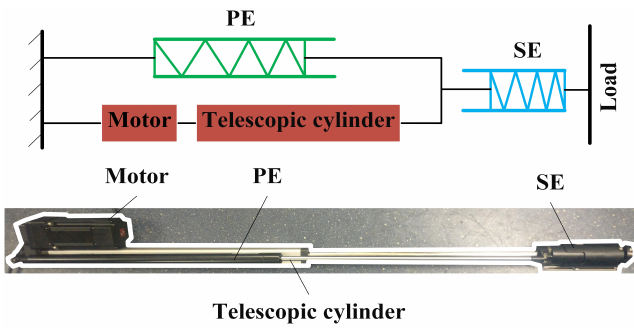
Figure 2. Series-parallel elastic actuator of PALExo.